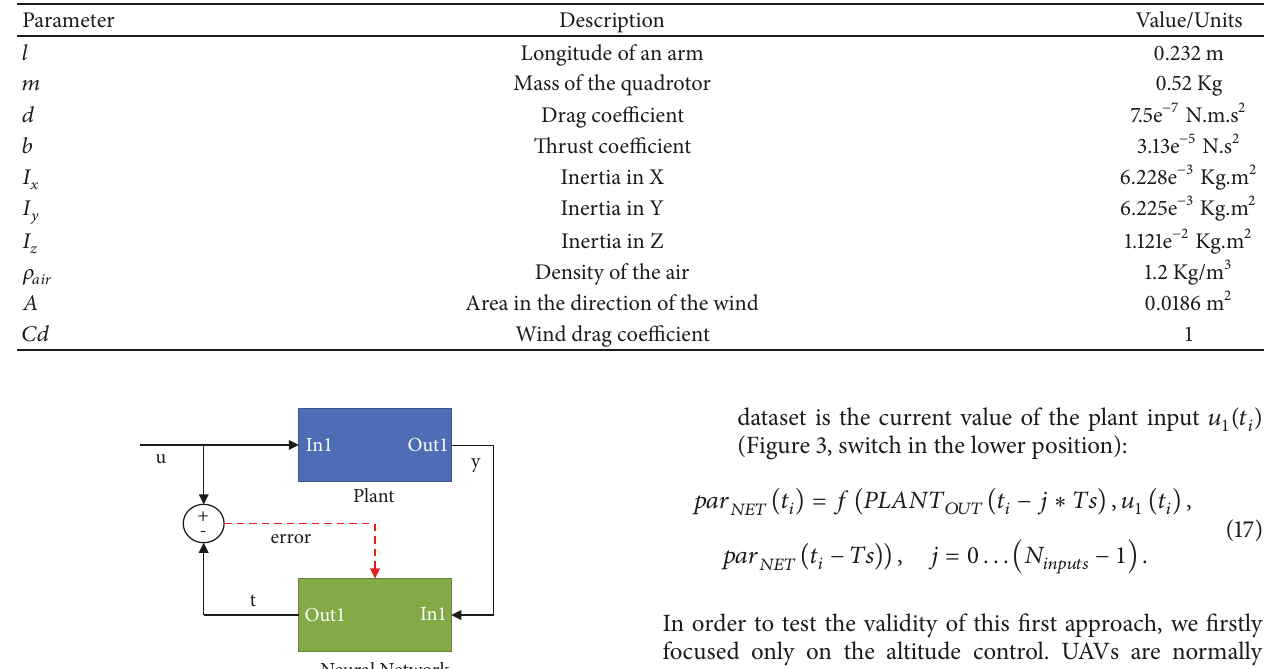
Table 1: Parameter values of the model.